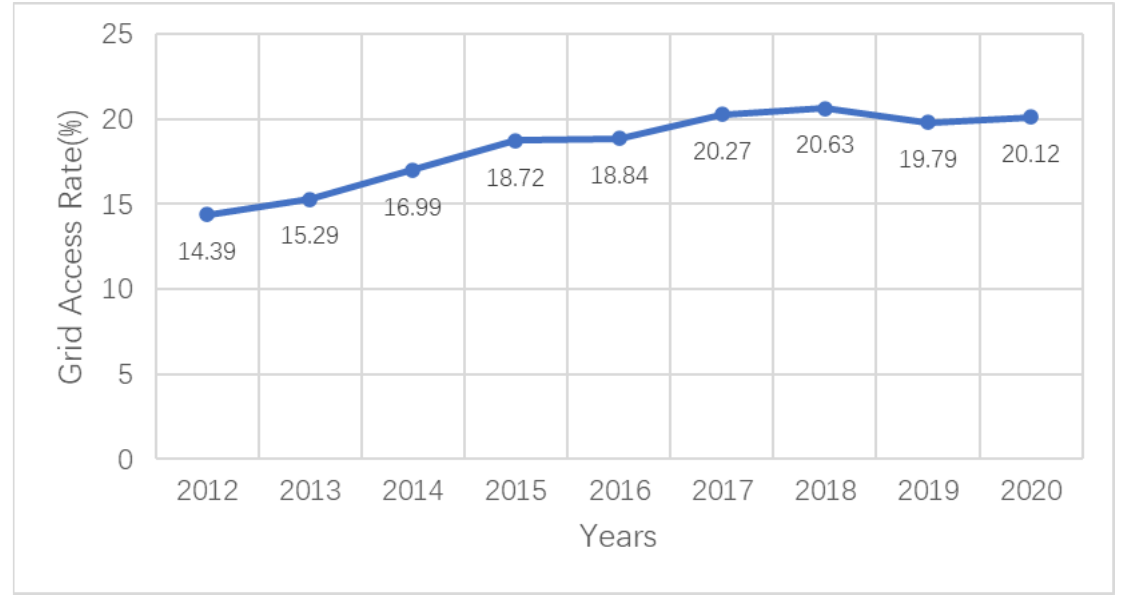
Figure 16. Grid access rate of Rwanda from 2012 to 2020.